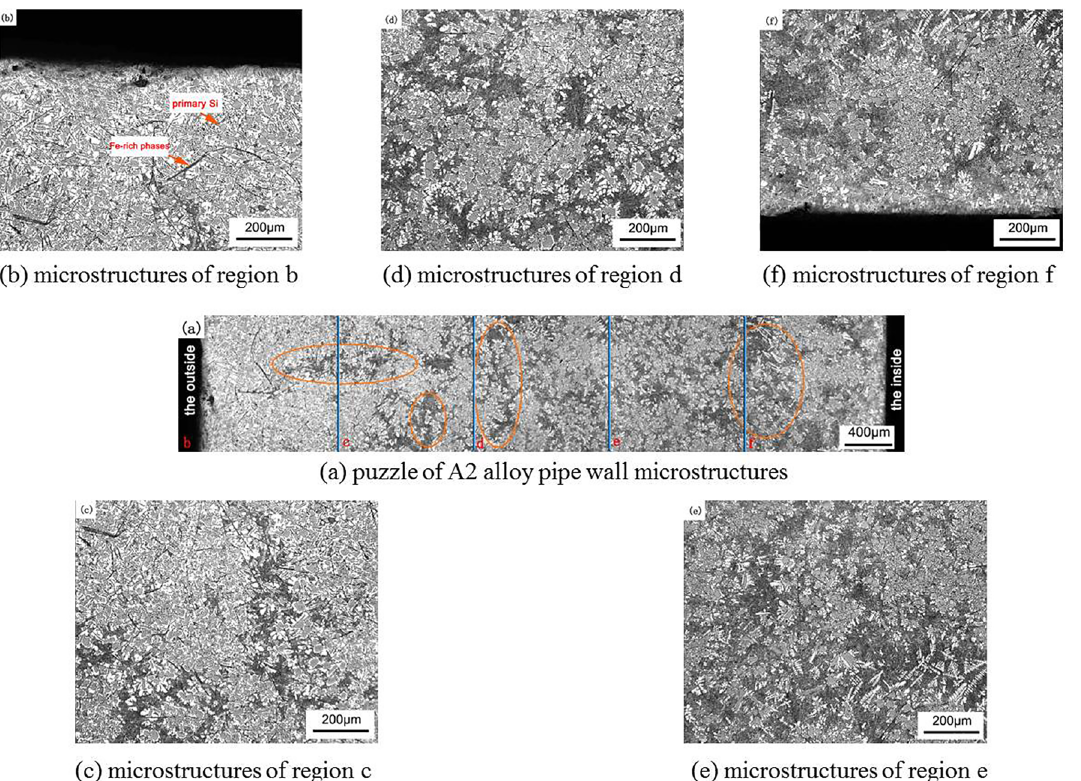
Figure 5. Rheo-squeeze casting A2 alloy pipe wall with gradient structure (a) puzzle of A2 alloy pipe wall microstructures; (b - f) microstructures of regions b -